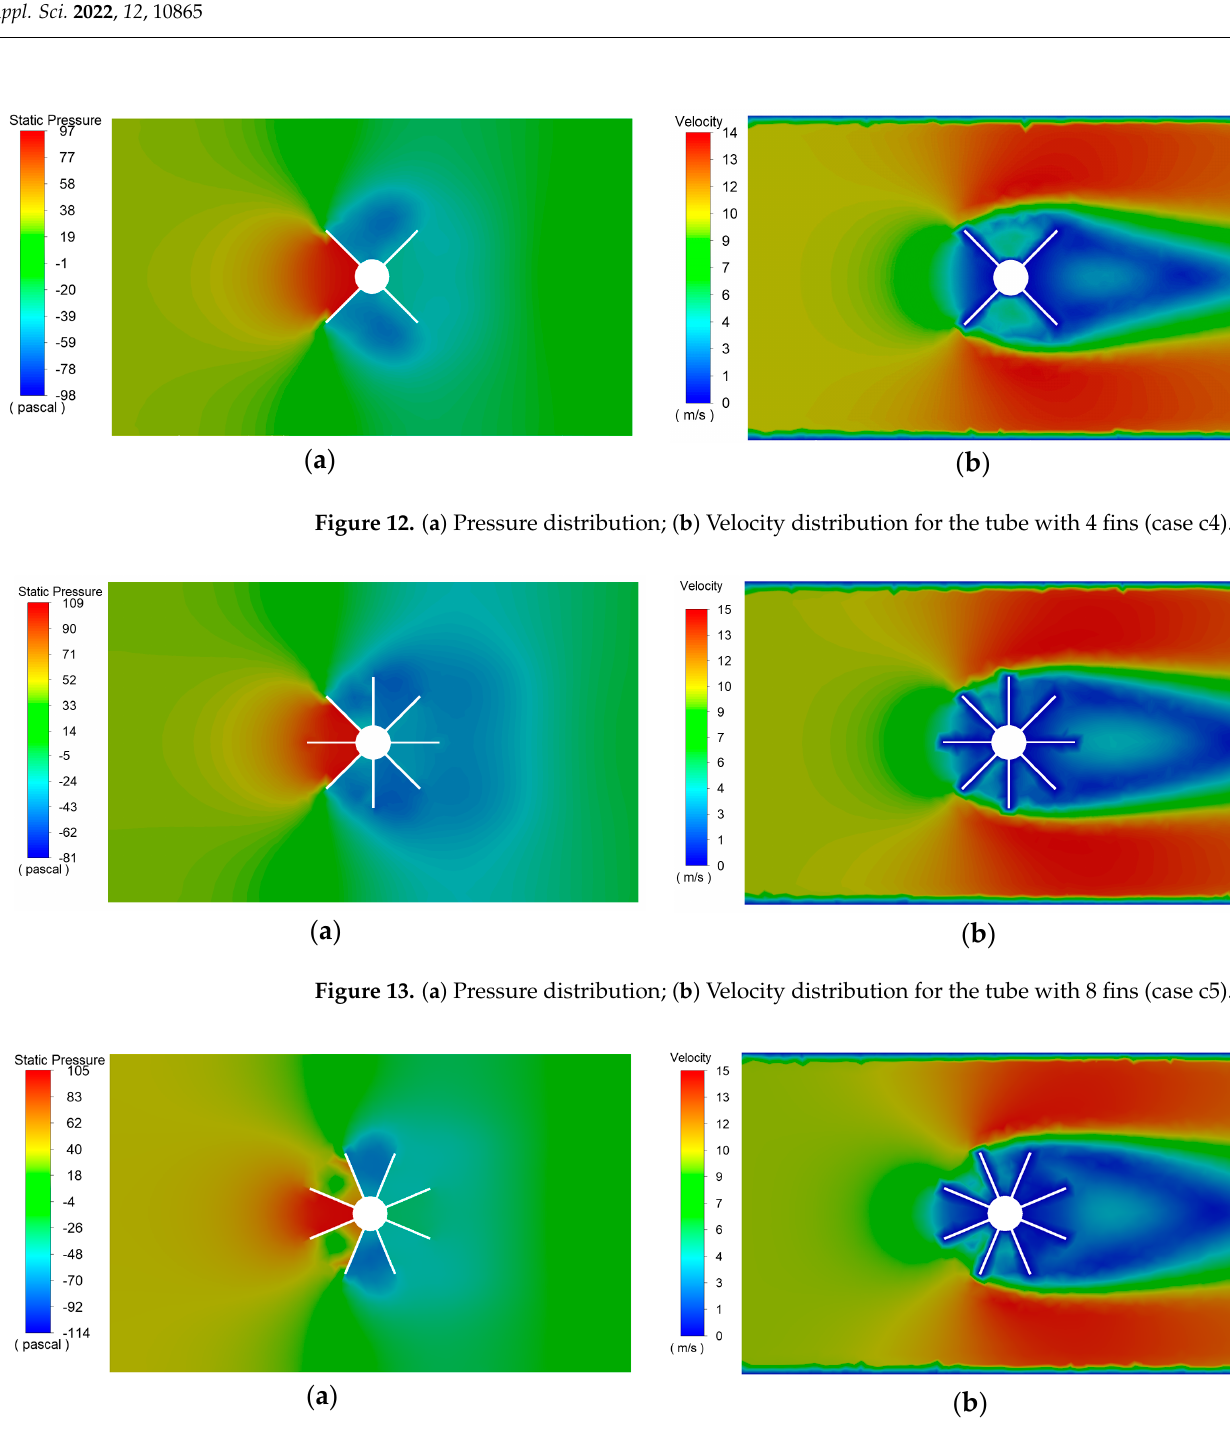
Figure 14. ( a ) Pressure distribution; ( b ) Velocity distribution for the tube with 8 fins (case c6). For each of the analyzed cases, except for the case c1, the aerodynamic drag coefficients obtained by the CFD method were, respectively, higher than the values obtained from the experiment. The differences ranged from 0.06 to 0.14, which is from 4% to 10%. These differences result from the fact that in the case of the experimental tests, the finned tube profiles were mounted on a cylindrical support of the force balance. Additionally, a short length of cylindrical pipe protruded at the top of the finned tube profiles. The reference areas of those elements were included in the calculations. In turn, in the CFD analysis, the cylindrical support of the force balance and the short tube section at the top were not modeled, which is reflected in the